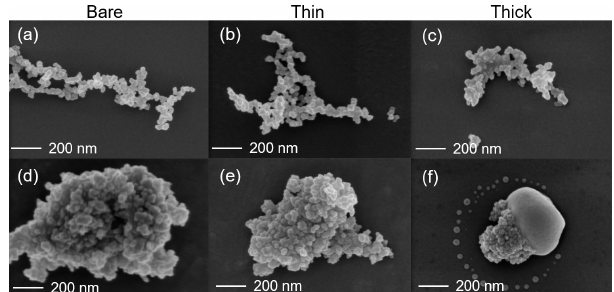
Figure 8. SEM images (Zeiss Leo 1530, Signal = InLens, EHT = 3kV) for 400nm size-selected bare and coated mCAST- black and FW200 soot particles. Scale bars are indicated in each image. (a) Bare mCASTblack, (b) mCASTblack with a thin coating (coating wt = 1.9%), (c) mCASTblack with a thick coating (coat- ing wt = 31.1%), (d) bare FW200, (e) FW200 with a thin coating (coating wt = 1.8%), and (f) FW200 with a thick coating (coating wt =